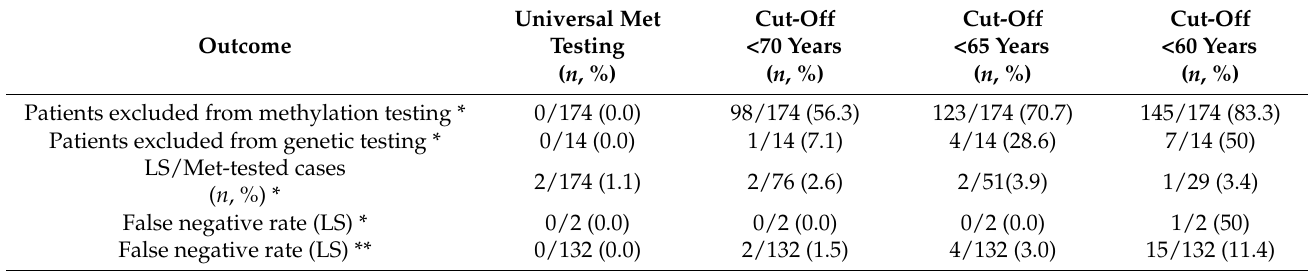
Figure 3. Age distribution of MLH1 mutation carriers diagnosed with EC in the LS registry-based cohort ( n = 132). Table 3. Comparison of universal and selective MLH1 methylation testing methods according to different age